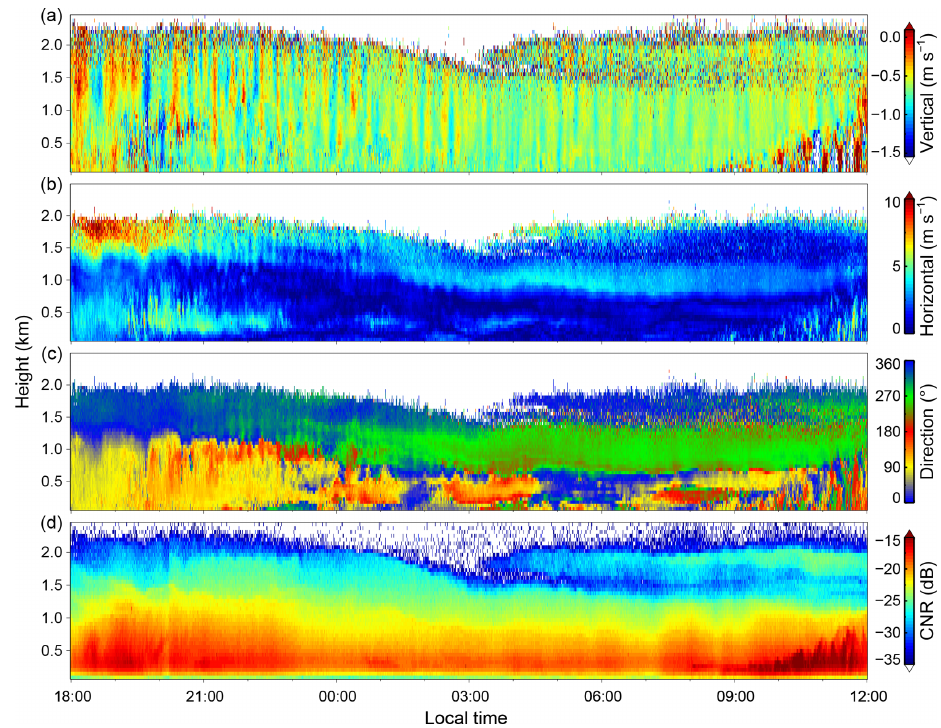
Figure 2. Height–time cross sections of the (a) vertical wind speed, (b) horizontal wind speed, (c) horizontal wind direction and (d) CNR from the vertical beam obtained by the CDL from 4 to 5 September 2018. The direction is defined as the angle clockwise from north.